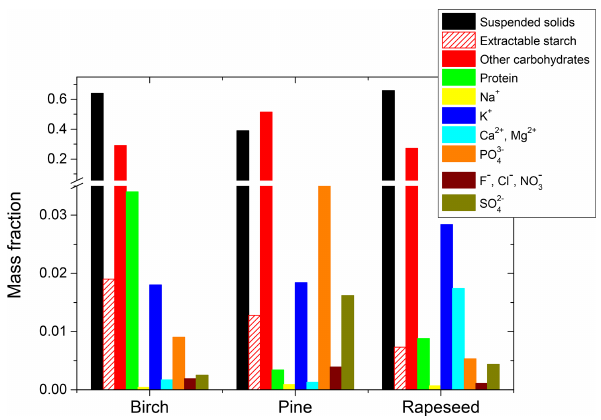
Figure 1. Mass fraction of dissolved and suspended species in the filtered solution of pollen